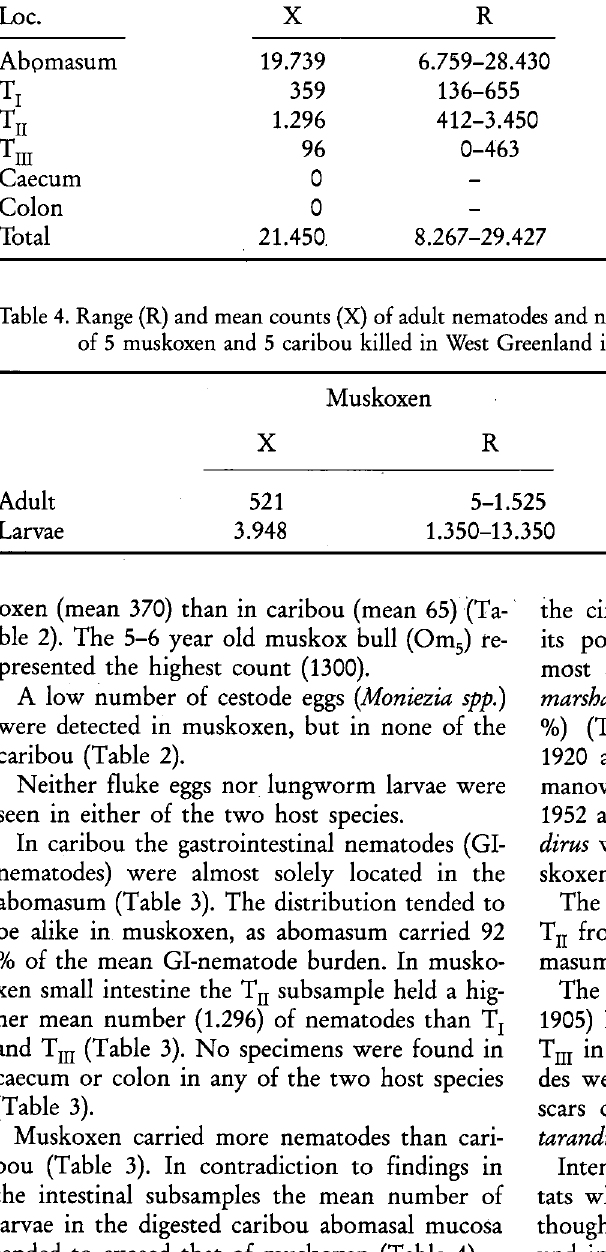
Table 4. Range (R) and mean counts (X) of adult nematodes and nematode larvae in the digested abomasal mucosa of 5 muskoxen and 5 caribou killed in West Greenland in